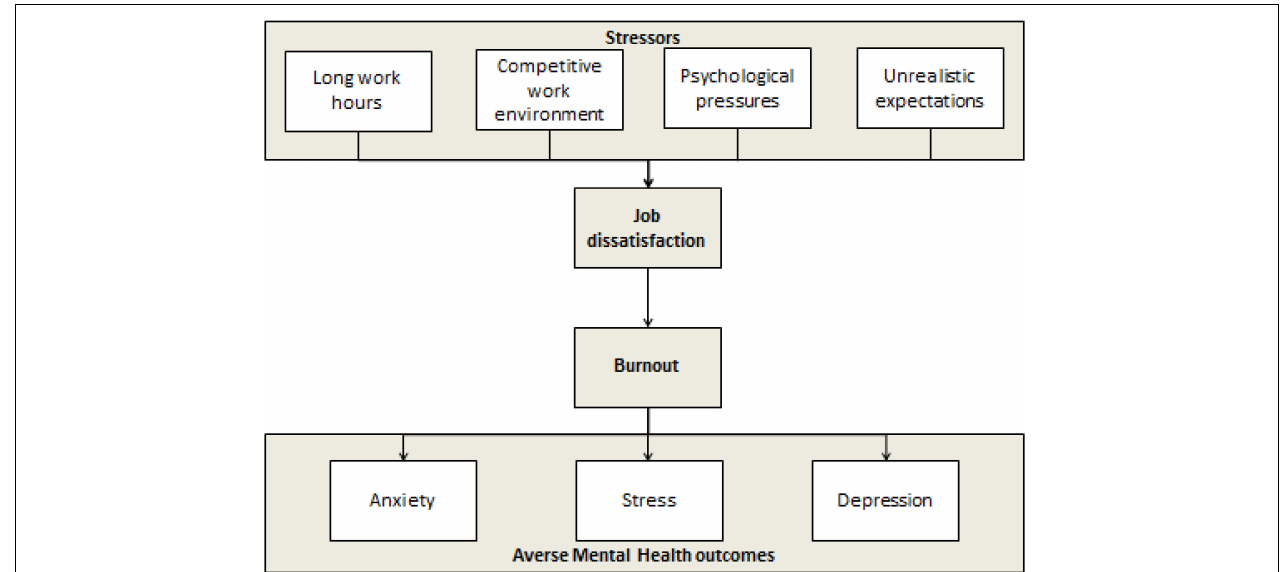
FIGURE 1 | Associations among work-stressors, job dissatisfaction, burnout, and mental